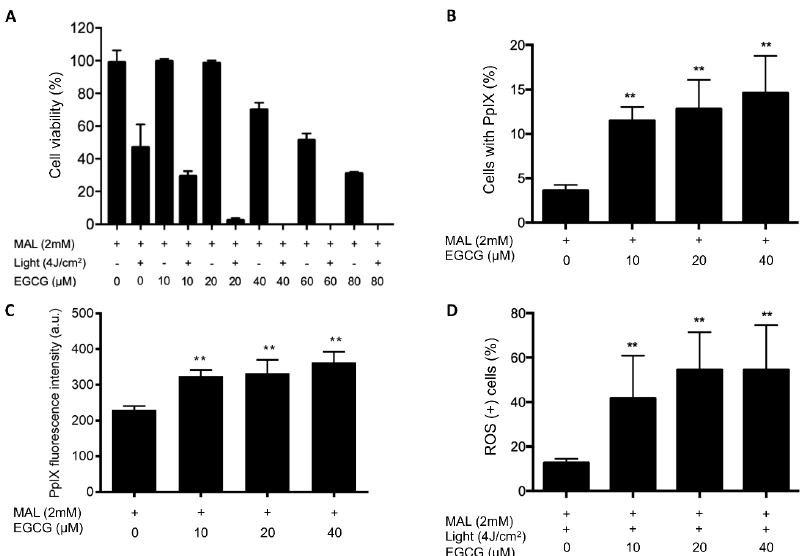
Figure 5. Combined effect of PDT and EGCGT in PDT-resistant HSC-1 cells. ( A ) Cell viability in PDT-resistant HSC-1 cells treated with EGCG. ( B ) Positive cells for PpIX production in PDT-resistant HSC-1 cells treated with MAL and EGCG at different concentrations. ( C ) PpIX fluorescence intensity in PDT-resistant HSC-1 cells treated with MAL and EGCG at different concentrations. ( D ) ROS production in PDT-resistant HSC-1 cells with combined therapy (PDT + EGCG). Each experimental group was compared with their respective control, either MAL (2 mM) or MAL (2 mM) + Light (4 J / cm 2 ). Values of P < 0.05 were considered statistically significant. a.u. = arbitrary units; ** p < 0.01. Data were expressed as mean ± SD of three biological